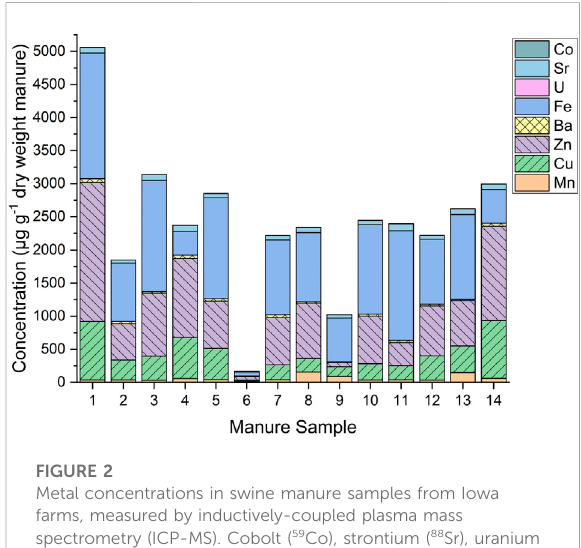
FIGURE 2 Metal concentrations in swine manure samples from Iowa farms, measured by inductively-coupled plasma mass spectrometry (ICP-MS). Cobolt ( 59 Co), strontium ( 88 Sr), uranium ( 238 U),iron( 56 Fe),barium( 137 Ba),zinc( 66 Zn),copper( 65 Cu),and manganese ( 55